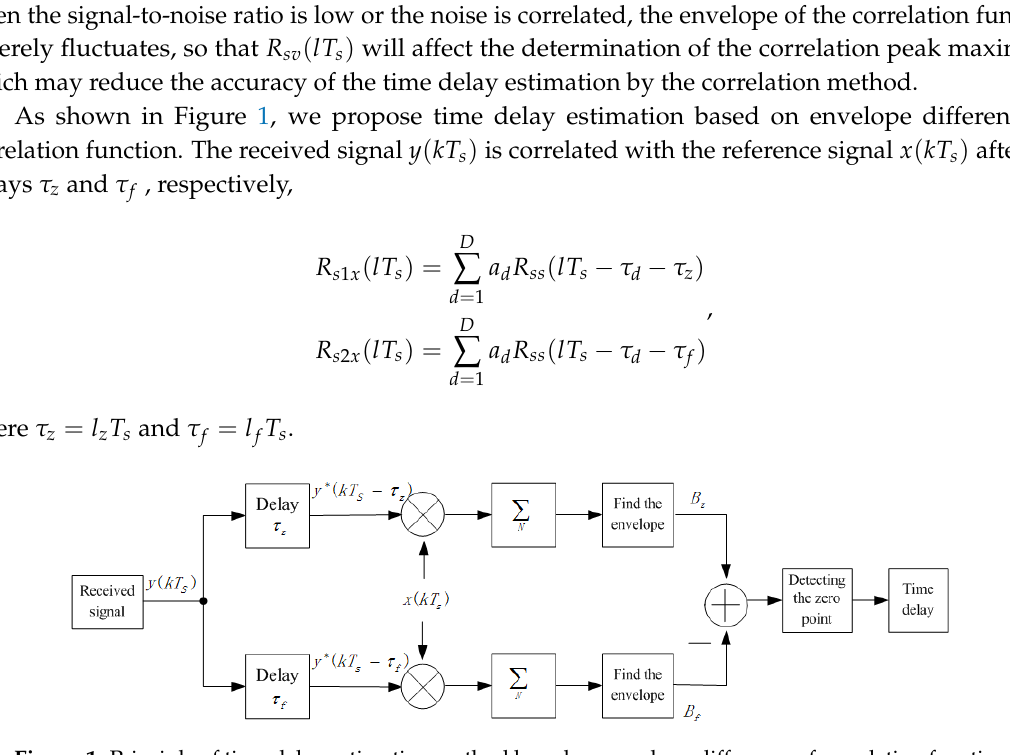
Figure 1. Principle of time delay estimation method based on envelope difference of correlation